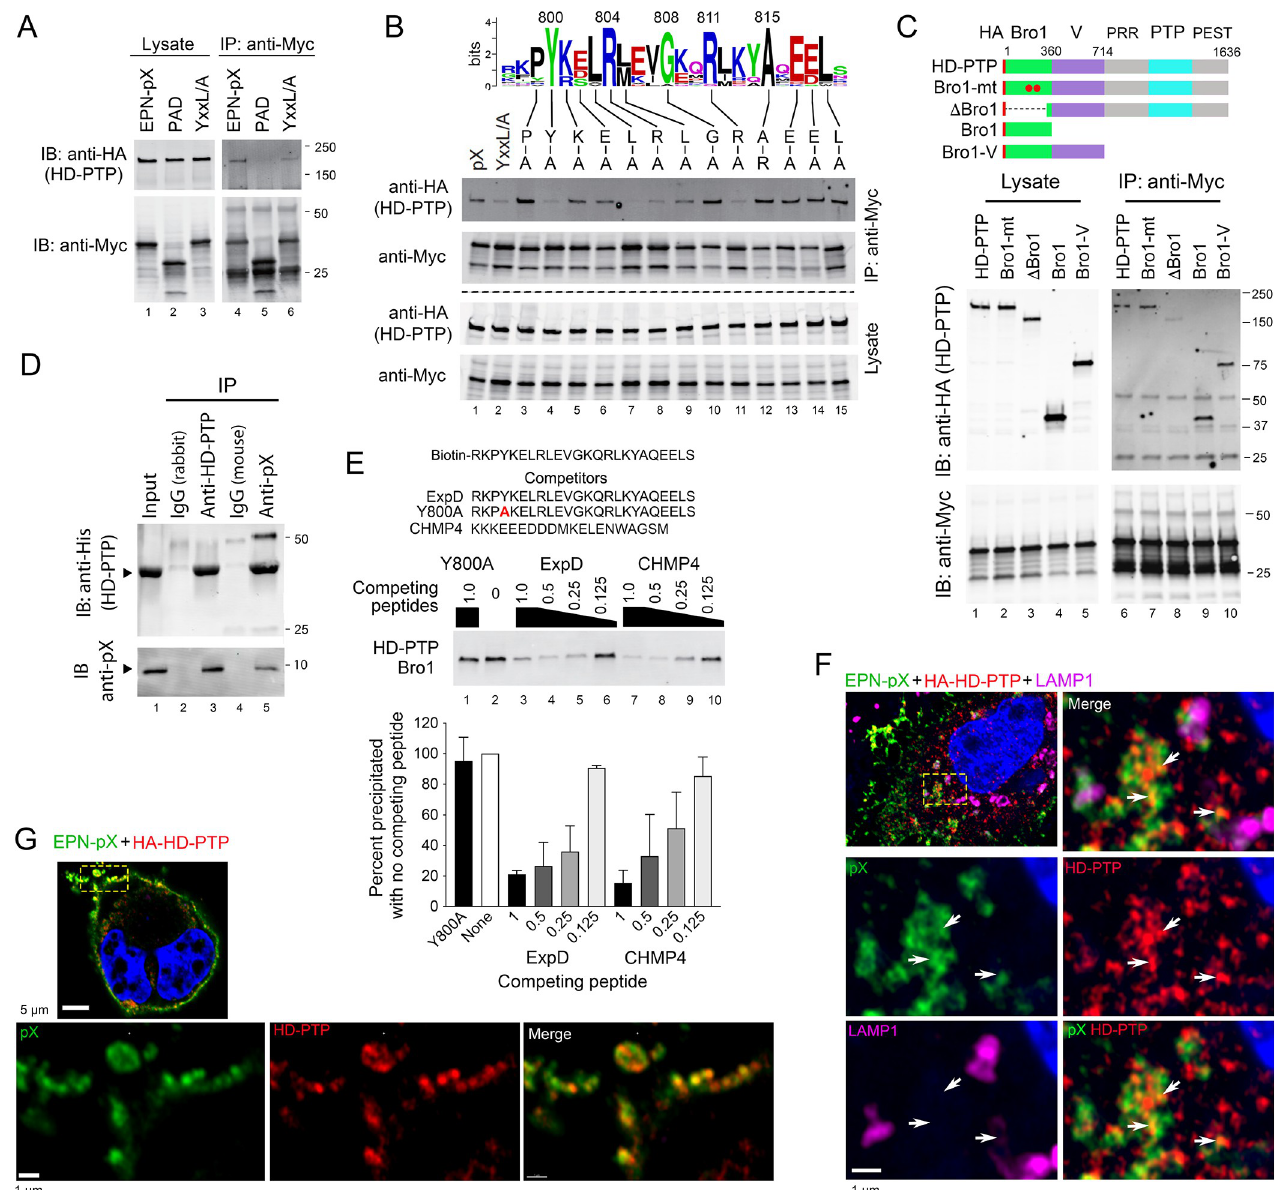
Fig 5. pX interacts directly with the Bro1 domain of the ALIX paralog, HD-PTP. (A) Co-immunoprecipitation of HA-tagged HD-PTP with EPN-pX. Proteins in lysates of cells expressing EPN-pX, EPN-PAD, or EPN-YxxL/A (Fig 2A) were precipitated with anti-Myc antibody and immunoblotted with antibody to HD-PTP. (B) Co-immunoprecipitation assays of HD-PTP with EPN-pX mutants containing single amino acid substituitions of conserved residues in the ExpD sequence. See Fig 3C. (C) Co-immunoprecipitation assays of EPN-pX with HD-PTP, HD-PTP with L202D and I206D substitutions in the Bro1 domain that eliminate CHMP4 binding (Bro1-mt) [43], and various HD-PTP domain fragments. PRR, proline-rich region; PTP, protein tyrosine phosphatase; PEST, “rich in proline, glutamate, serine and threonine” [51] (D) Co-immunoprecipitation of bacterially-expressed pX and recombinant HD-PTP Bro1 protein (residues 1–360) produced in E . coli . (E) Biotin-tagged ExpD peptide pulldown assay of HD-PTP Bro1 domain (residues 1–360) produced by in vitro transcription/translation in rabbit reticulocyte lysate. See legend to Fig 4G for details. (F) Merged low magnification ( top left ) and merged and single-channel enlarged super-resolution Airyscan fluorescence images of the area demarcated by the yellow lines showing pX (green), HD-PTP (HA, red), and LAMP1 (magenta) in a 293T cell expressing EPN-pX and HA-HD-PTP. Arrows indicate sites of pX colocalization with HD-PTP. (G) Similar low magnification (top image) and enlarged super-resolution images showing co-localization of pX and HD-PTP along the plasma membrane.